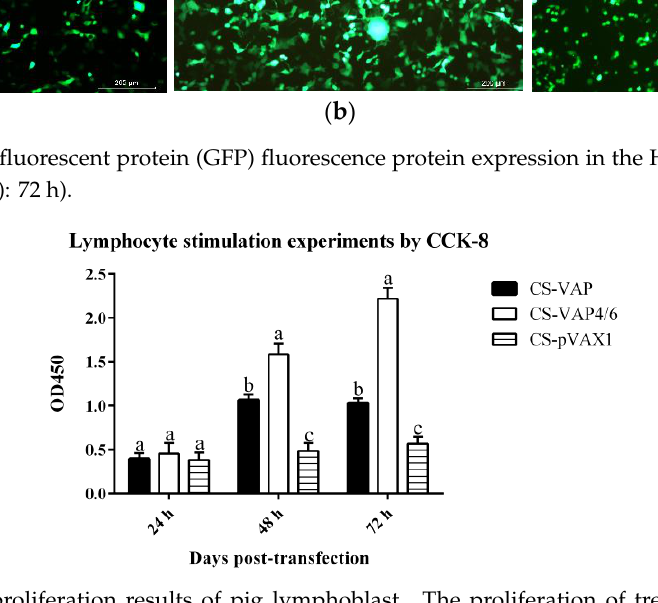
Figure 4. The proliferation results of pig lymphoblast. The proliferation of treated groups had significant proliferations compared with the control group ( p < 0.05), and the proliferation of CS- VAP4/6 was higher than CS-VAP at 48 and 72 h ( p < 0.05). Each datum is the average of three replicates. The followings are the same as here.